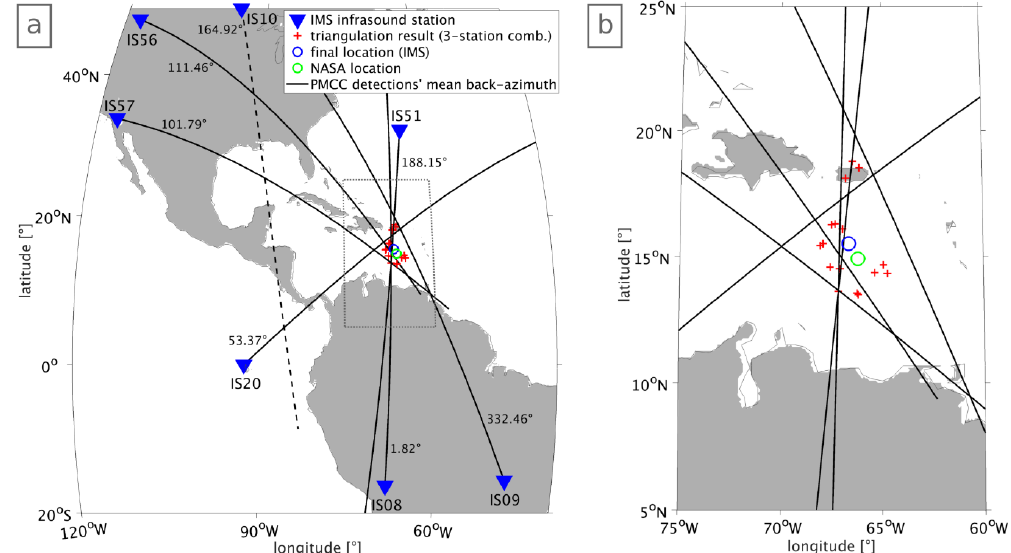
Figure 1. ( a ) Overview of the triangulation method applied for the Caribbean fireball event in June 2019 and ( b ) map section around the determined location. For locating the fireballs using the International Monitoring System (IMS) infrasound network, the detected backazimuths are projected along the great-circle propagation path for three stations at a time. If three intersection points are found—i.e., all of these projections intersect—their geographical center is the triangulation result (red cross) of this three-station combination. This procedure is subsequently repeated for all conceivable combinations of three stations that detected the event. The actual location is calculated as the longitudinal and latitudinal mean (blue circle) of the single triangulation results. The location published by NASA’s Center for near-Earth object studies (CNEOS) [22] is denoted by a green circle. If a Progressive Multi-Channel Correlation (PMCC) backazimuth deviates from the latter by more than 10 ◦ —e.g., the dashed line stations remain utilizable.